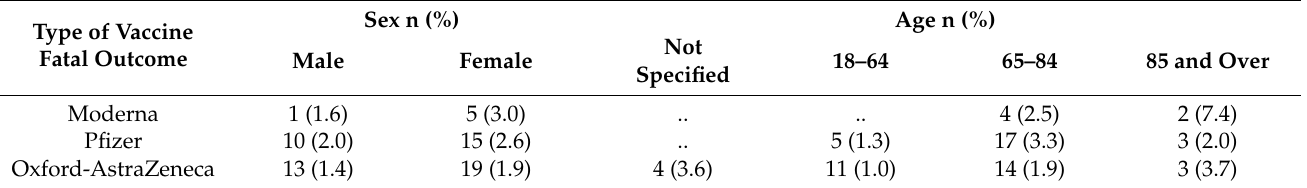
Table 4. Summary of reports with fatal outcome in relation to age and sex for each type of vaccine.